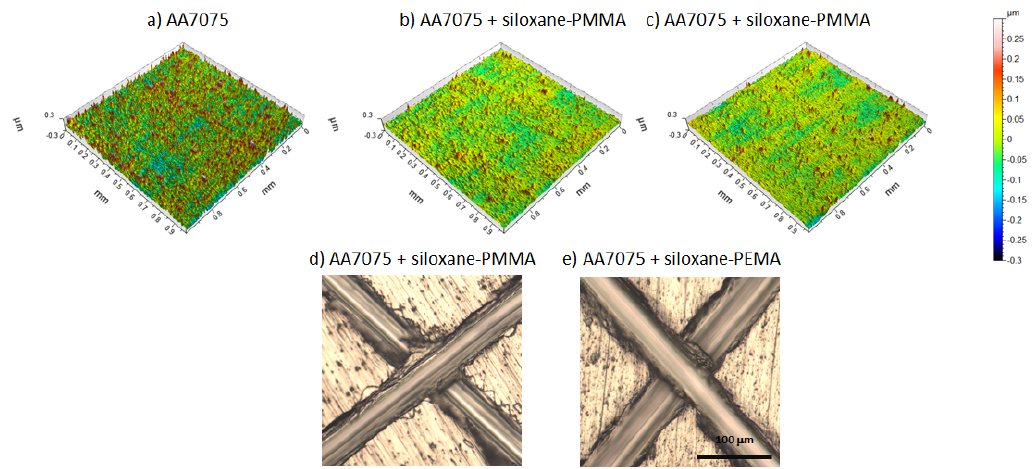
Figure 7. ( a – c ) 3D topography images of bare AA7075 and AA7075 coated with siloxane-PMMA and siloxane-PEMA. Colour scale bar denotes the span of ± 0.3 µ m. ( d – e ) X-cut surfaces of AA7075-T6 substrates coated with siloxane-PMMA and siloxane-PEMA following the adhesion test - imaged by confocal microscope.